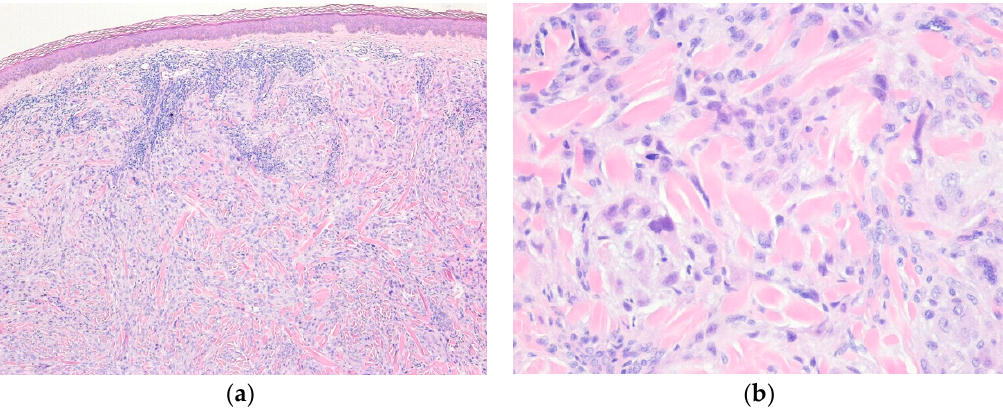
Figure 7. Cellular neurothekeoma. ( a ) At lower power, the tumor shows a nested growth pattern separated by sclerotic collagen; ( b ) The epithelioid tumor cells have pale eosinophilic cytoplasm. Mild nuclear atypia is also present (H&E stain, original magnifications 40× ( a ) and 200× ( b )).